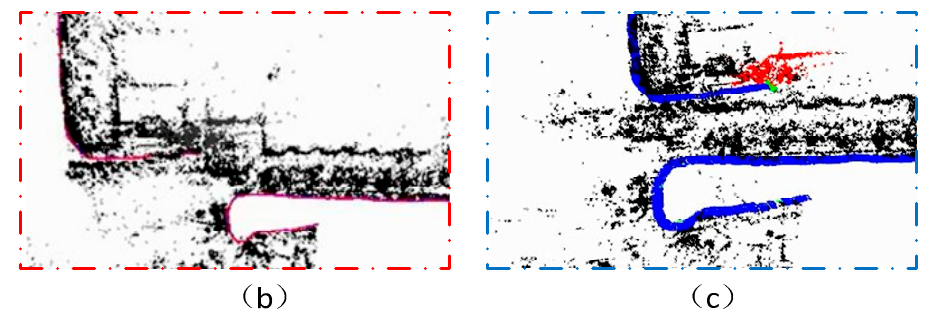
Figure 9. Trajectory in scene 2. ( a ) Comparison of the trajectory projection between the proposed method and the ORB-SLAM for monocular camera. ( b ) Using our method to reconstruct the results at the end. ( c ) Using the monocular SLAM to reconstruct the results at the end.